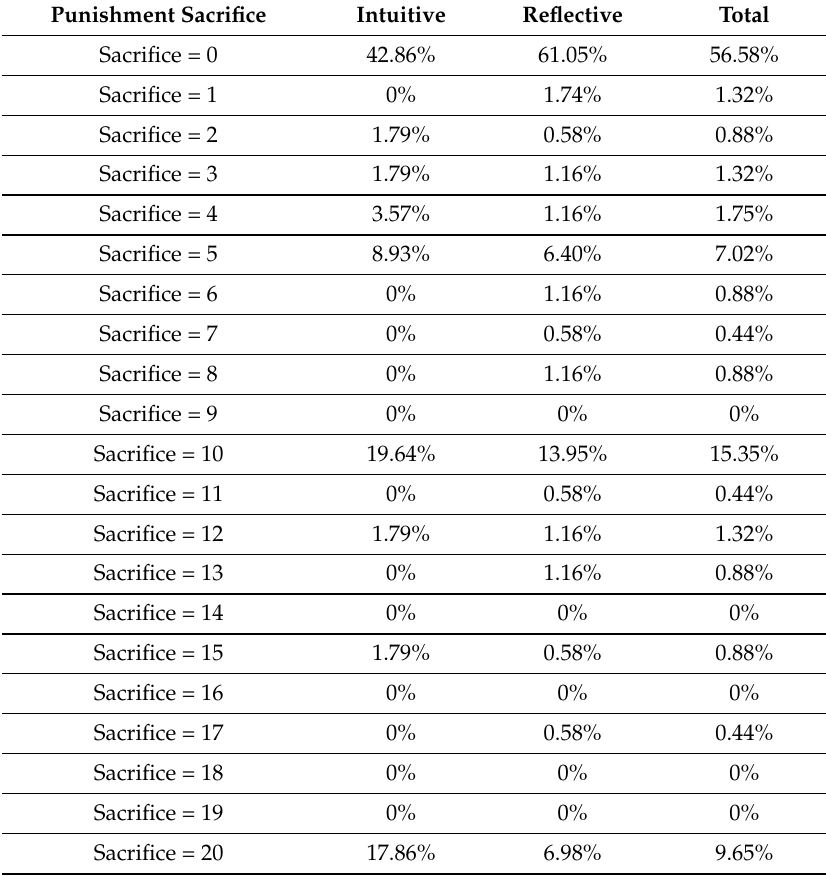
Table A4. Frequency of Punishment Sacrifice by Intuitive (Reflective)